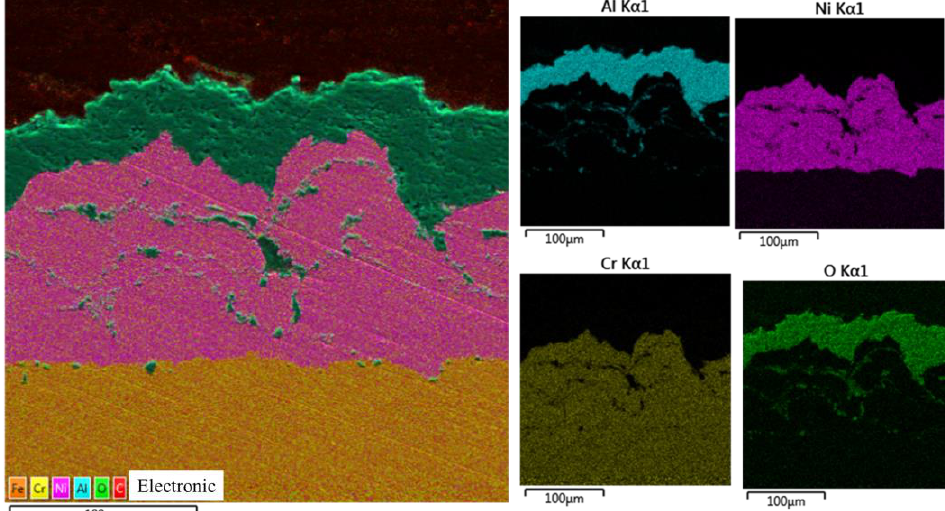
Figure 8. SEM images of the cross-sectional morphology of the five-layer gradient coating.